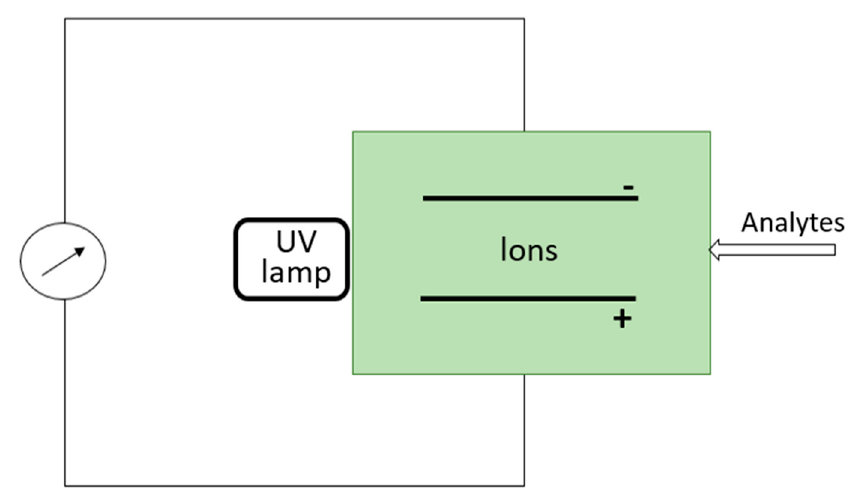
Figure 5. Photo ionization detector (PID).